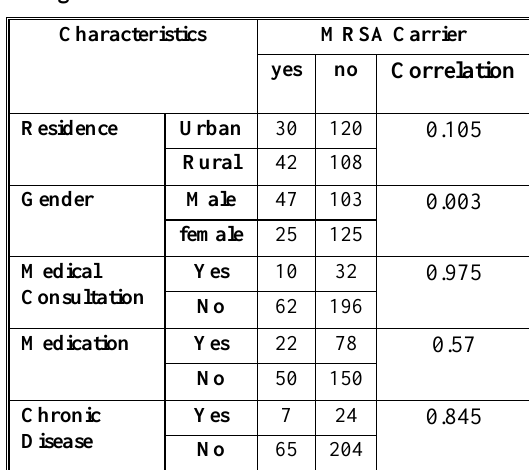
Table 2. Chi-square test of association between MRSA nose carriage and sociodemographic background of students.